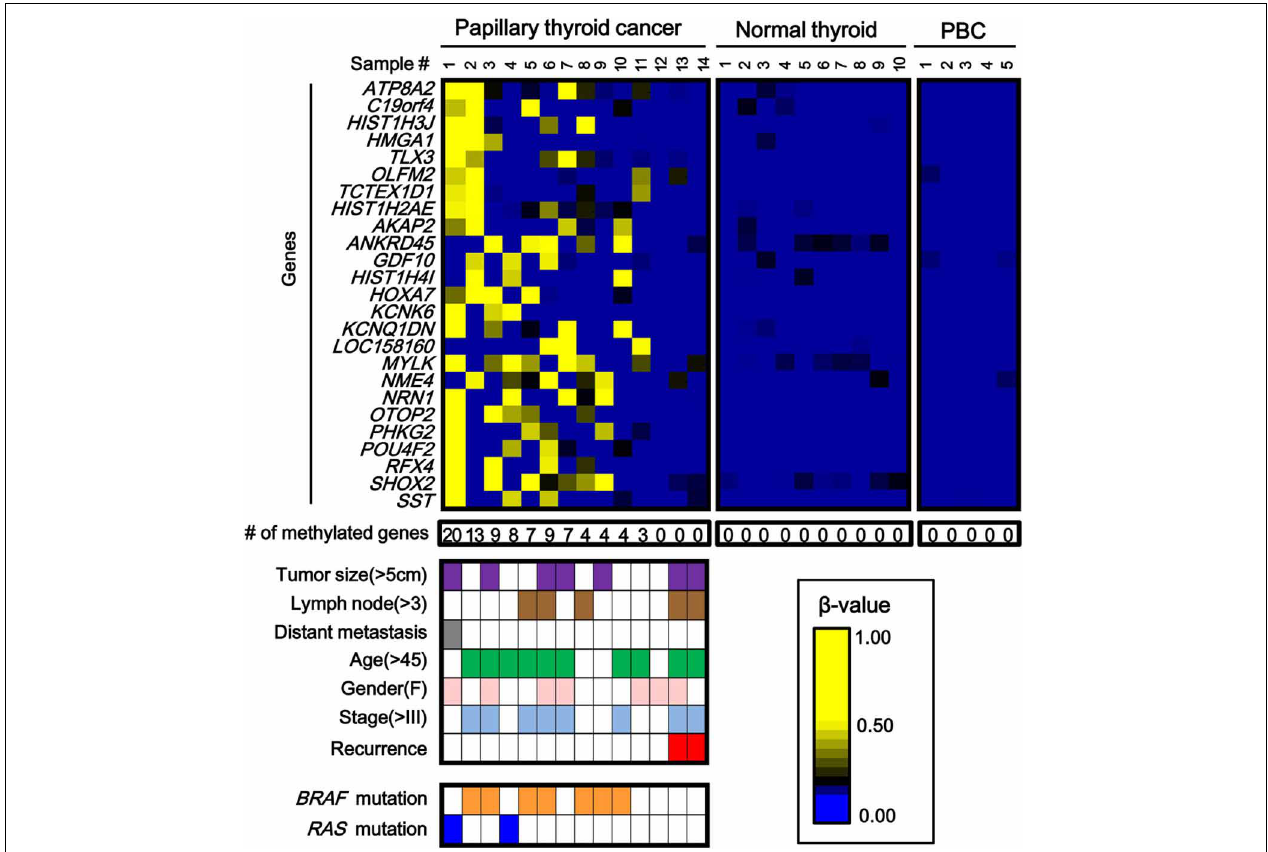
FIGURE 3 | Aberrantly methylated genes frequently observed in papillary thyroid cancer. PBC, peripheral blood cells. We detected 25 genes that were hypermethylated ( β > 0 . 25) in at least three of 14 papillary thyroid cancer samples, but not methylated ( β < 0 . 2) in 10 normal samples. Among the 14 papillary cancer samples, 11 showed aberrant methylation in three or more genes, whereas the other three samples had no aberrant methylation.